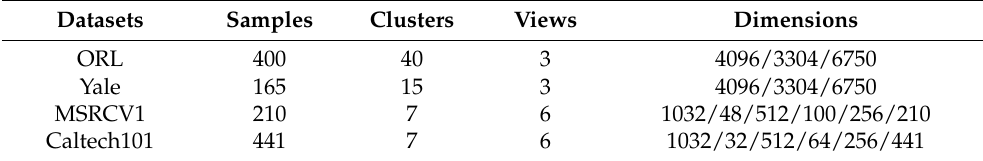
Table A1. Statistical information of the four multi-view